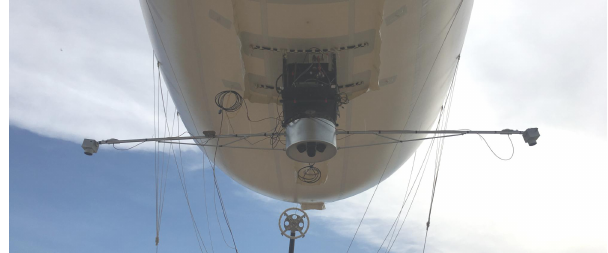
Figure 4. Mapping system mounted on the tethered balloon